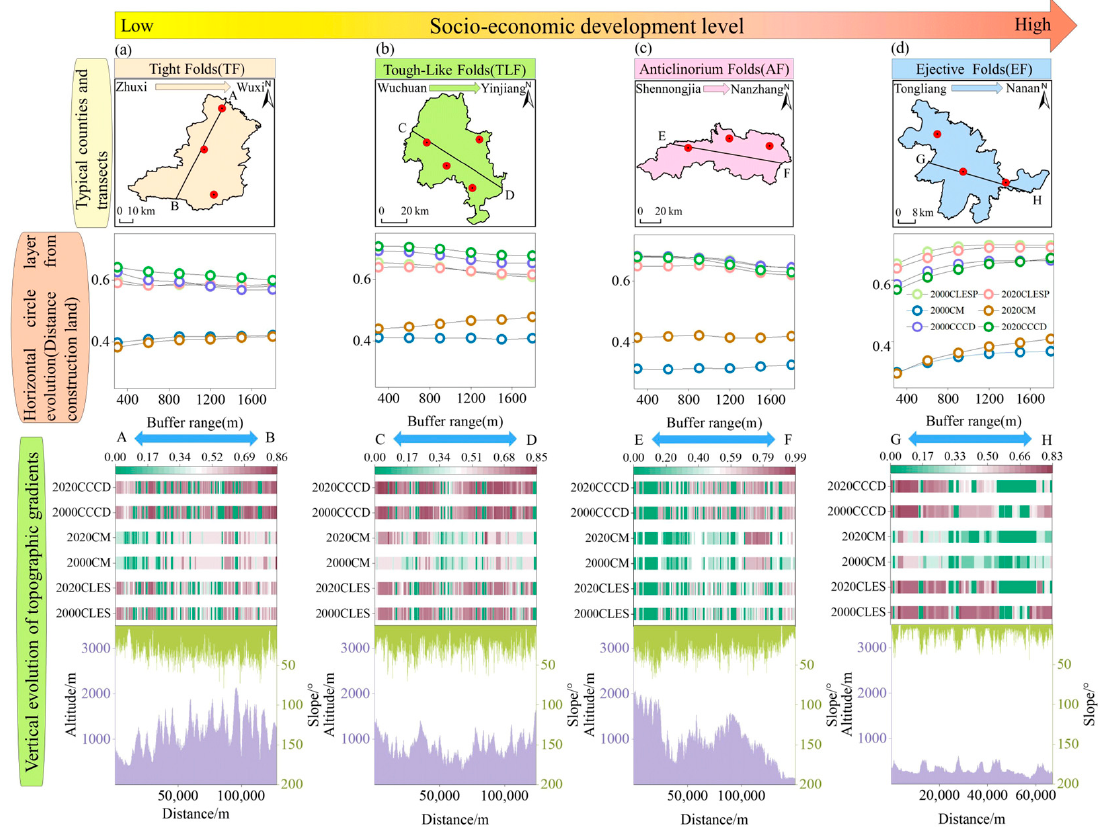
Figure 8. The evolution of vertical in topographic gradient and horizontal circle layer distance from construction land in typical counties in CLES, CM and CCCD: ( a ) in TF; ( b ) in TLF; ( c ) in AF; ( d ) in EF; CLES: cropland landscape ecological security; CM: cropland multifunctionality; CCCD: cropland coupling coordination degree.